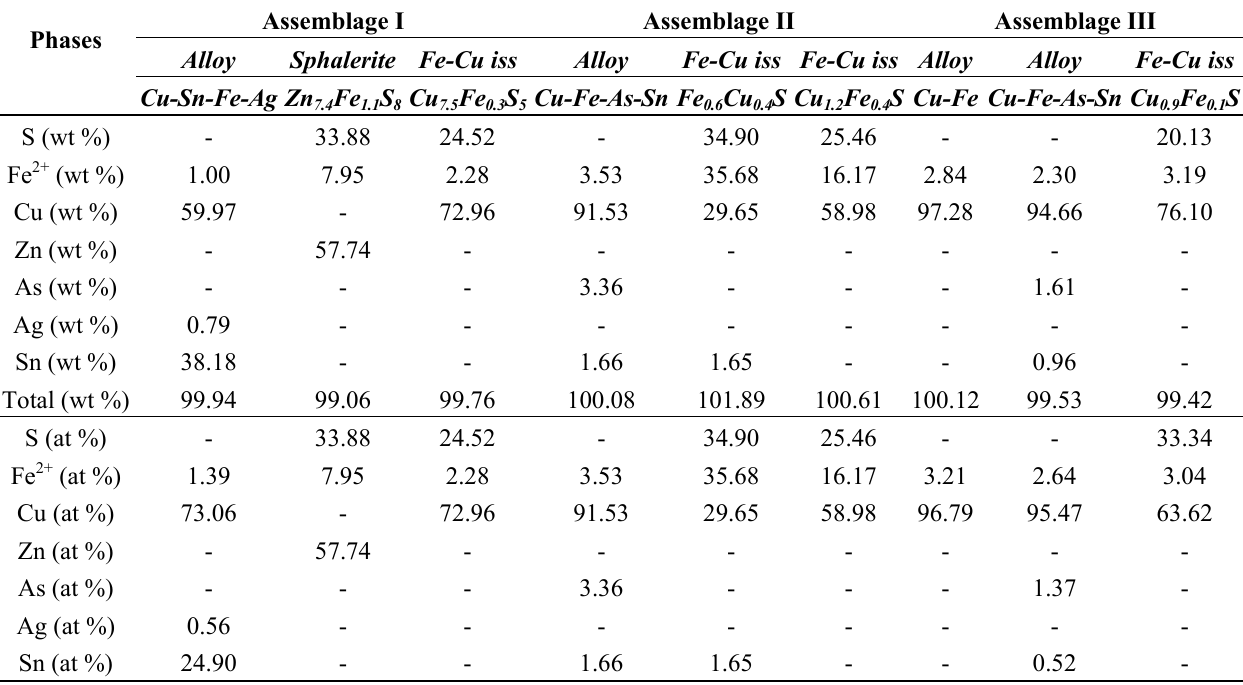
Table 4. Chemical compositions of matte drops obtained by EDS. “-” indicates non-detected. iss: intermediate solid